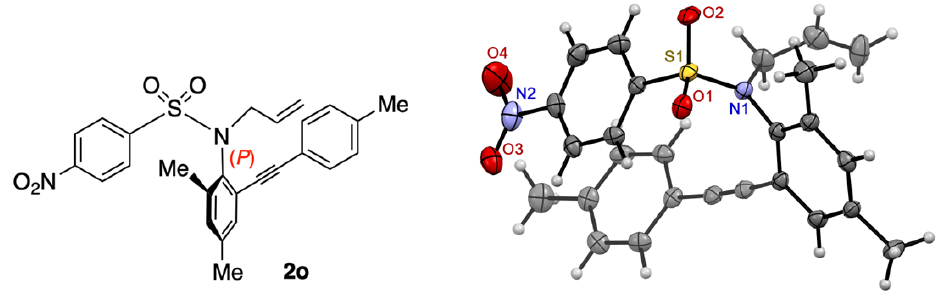
Figure 1. X-ray single crystal structure of 2o (major enantiomer).